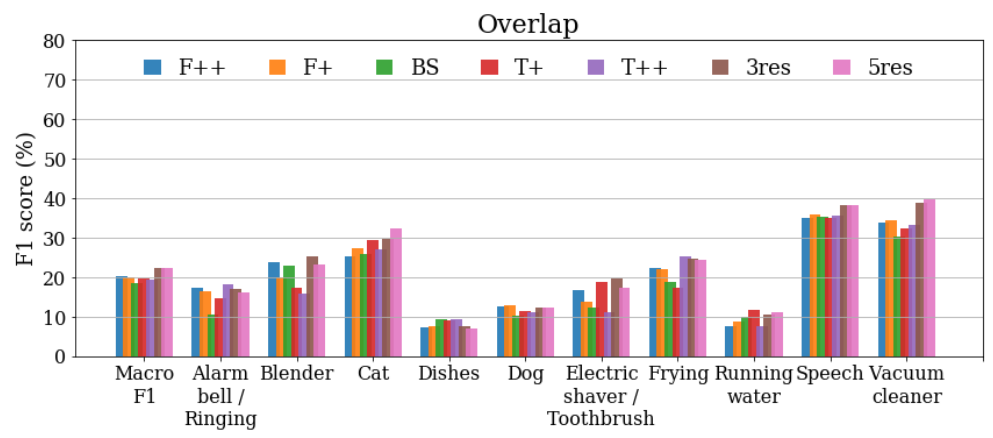
Figure 7. F 1 scores of single-resolution systems ( F ++ , F + , BS , T + , T ++ ) and multiresolution systems ( 3res , 5res ) over Overlapped set. “Macro F1” shows average score over 10 target categories. Best viewed in